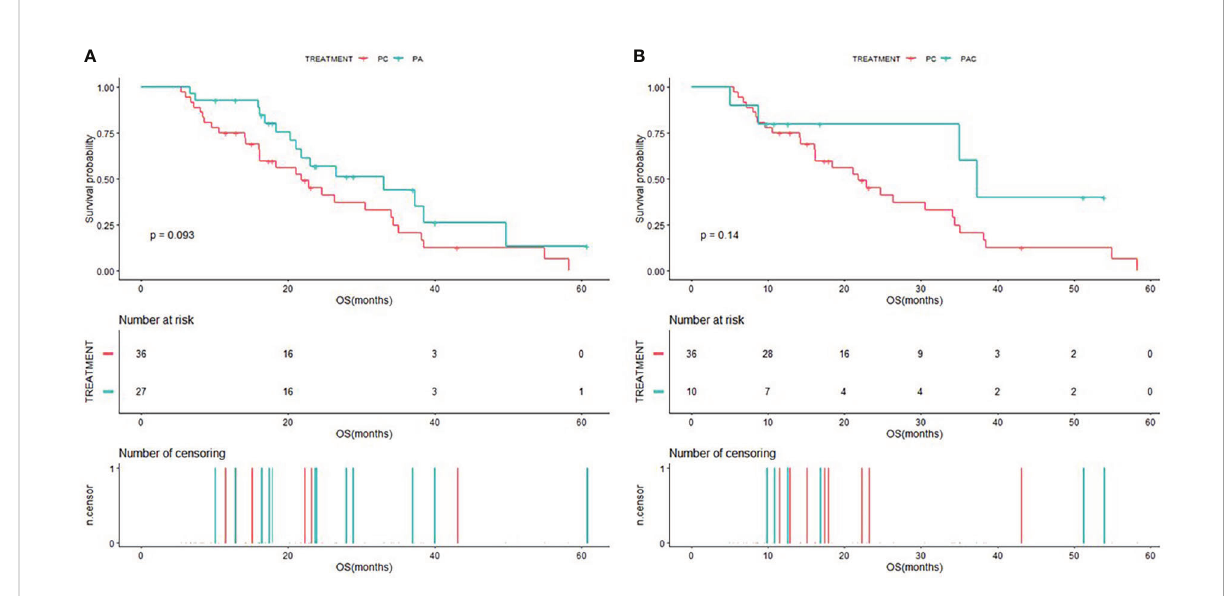
FIGURE 3 Kaplan-Meier (KM) curves of OS (A) of patients in PC group versus PA group and OS (B) of patients in PC group versus PAC